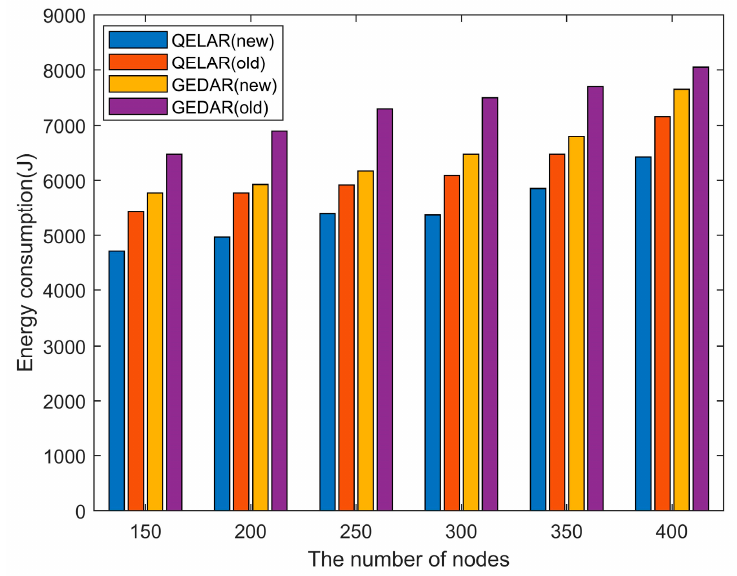
Figure 8. Comparison of total energy consumption for different architectures.